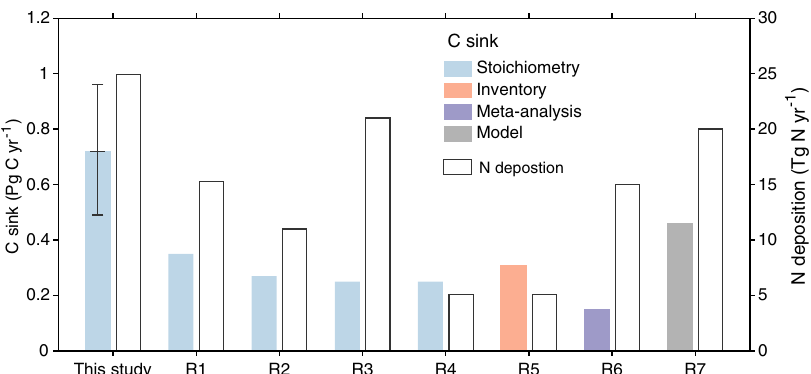
Fig. 4 Estimates of C sink in global forests due to atmospheric N deposition. In the current study, the C sink estimated due to N deposition (24.9Tg N yr − 1 ) on lands with >10% forest cover assumes that 80% of atmospheric N retained in the soil is immobilized in the soil organic matter (see Method). The contribution of NH x and NO y deposition to the total N-induced C sink in the global forests is shown in Supplementary Table 7. The error bar for the current study indicates mean ranges with 95% con fi dence interval ( n = 24,000, derived from four N deposition data×6C/N data×1000 Monte Carlo) (Method). Estimated C sinks induced by N deposition in global forest ecosystems reported by previous studies (R1-R7) which distinguished the effects of N deposition on C sinks are presented for comparison. References R1, R2, R3, R4, R5, R6, and R7 are De Vries et al. 36 , Du and de Vries 37 , Wang et al. 41 , Nadelhoffer et al. 19 , Thomas et al. 40